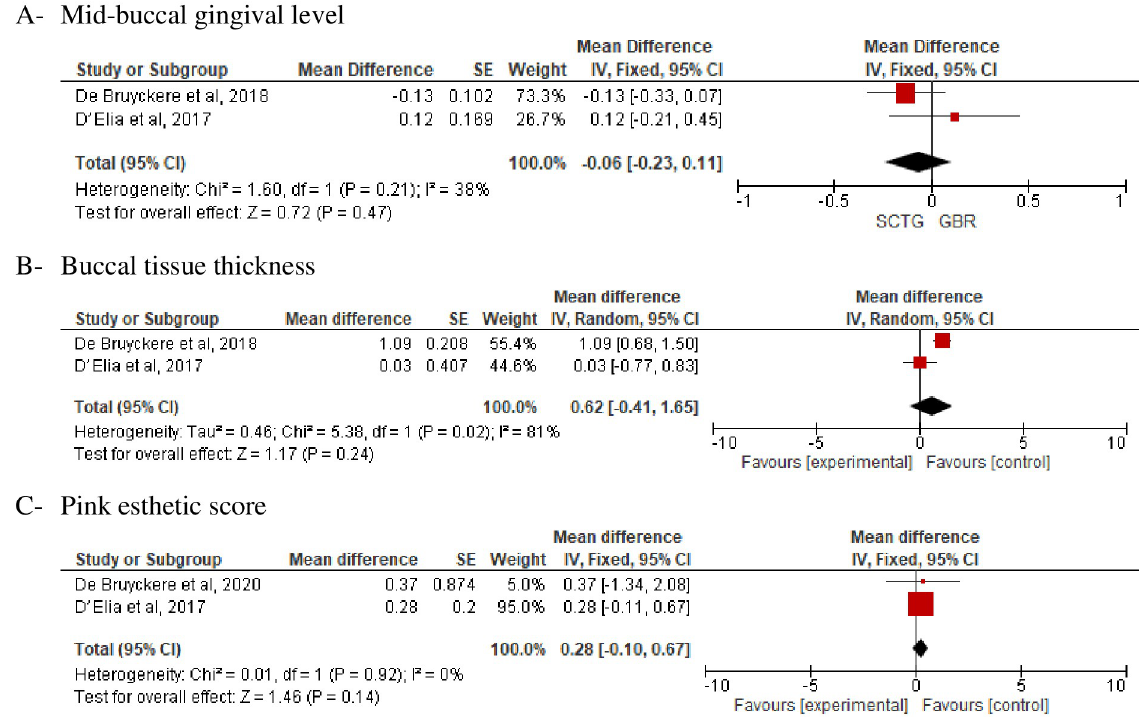
Fig 7. SCTG vs no augmentation plus GBR along with DIP. A) Mid buccal recession, B) Buccal tissue thickness, C) Pink aesthetic score.